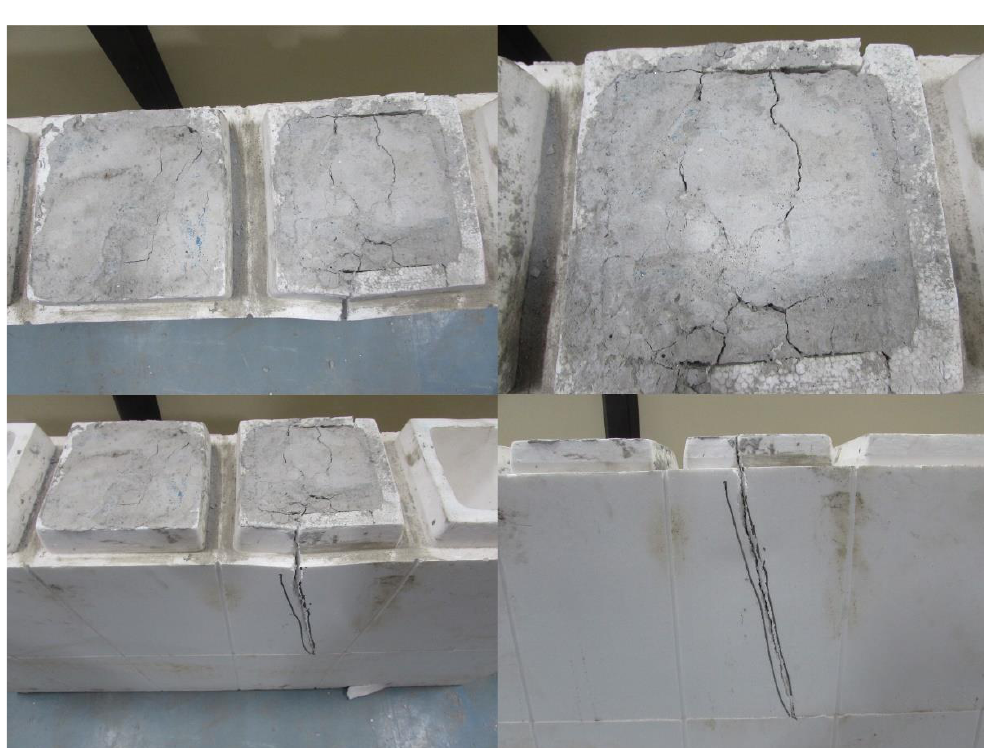
Figure 15. Failure pattern of ICF panels.